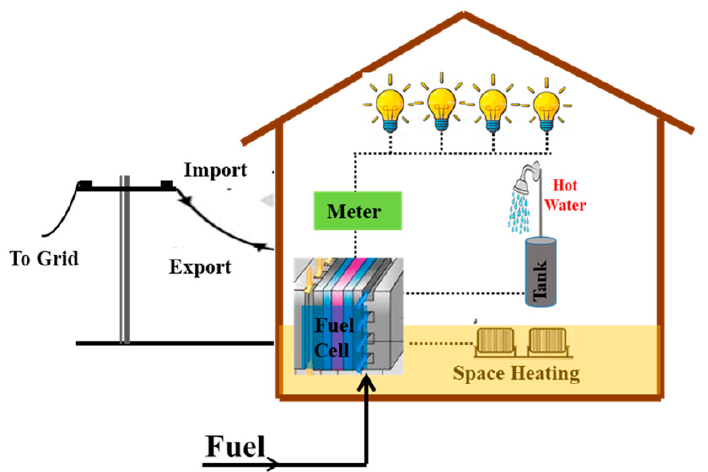
Figure 1. Fuel cell combined heat and power systems [24] (Published under open access).